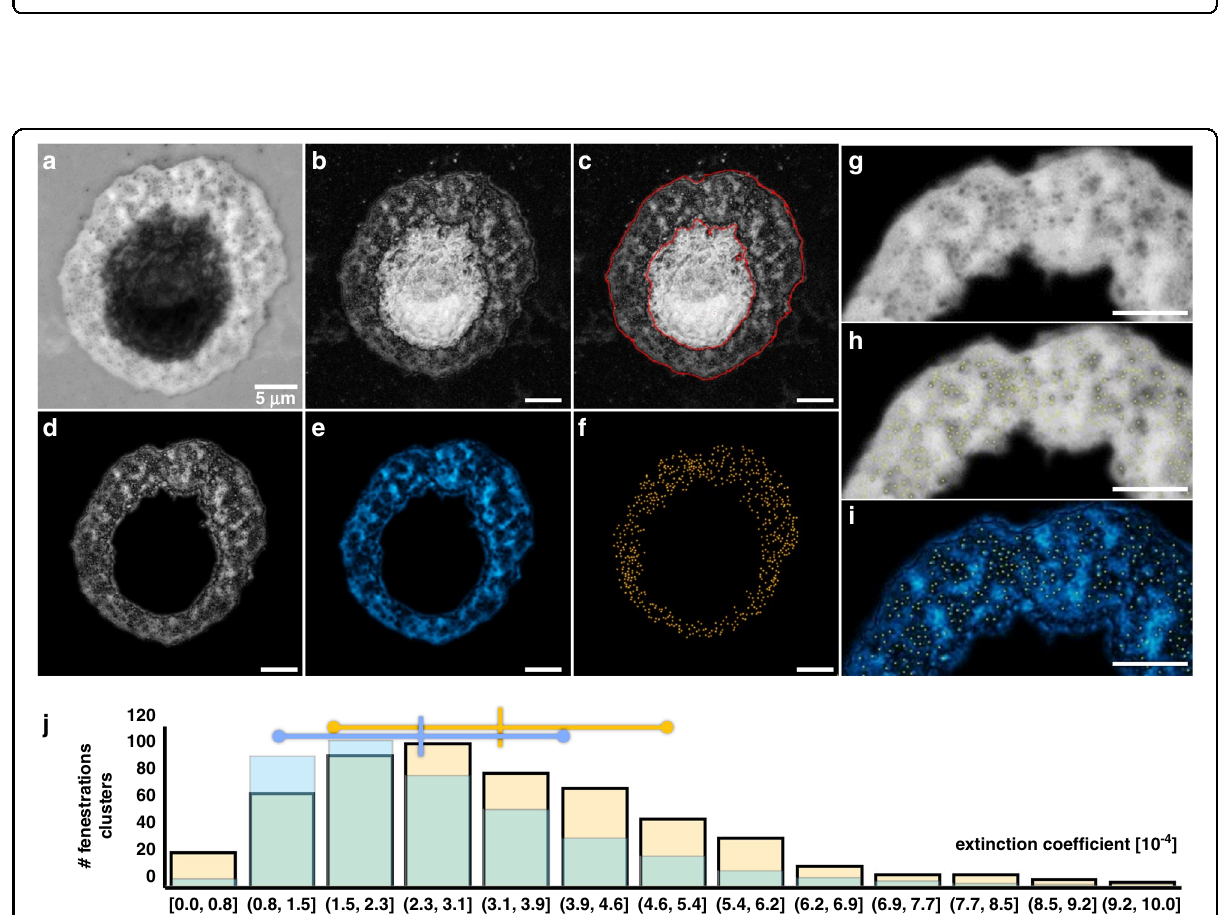
Fig. 5 Analysis of fenestration clusters. a UVC LSEC image. b Image after qDPC processing. c Segmentation of the plasma membrane using a Weka classi fi er 25 . d – f Separation of plasma membrane (blue) from fenestration clusters (orange) using a sliding paraboloid fi lter. g Enlarged view of ( a ). h , i Enlarged views of ( a ) and ( d ) with marked fenestration clusters. j Histogram of detected fenestration cluster extinction coef fi cients from ( f ) in yellow and extinction coef fi cient histogram in blue of the segmented plasma membrane in ( e ). The scale bars are 5